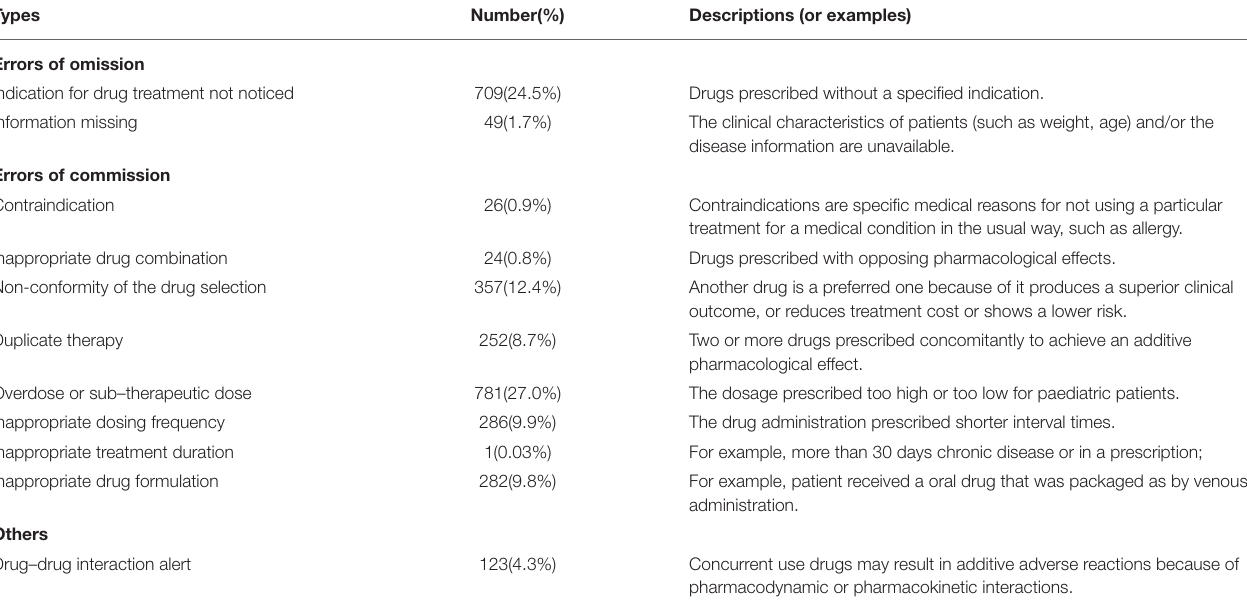
TABLE 1 | Classification and rates of prescription errors in this study.